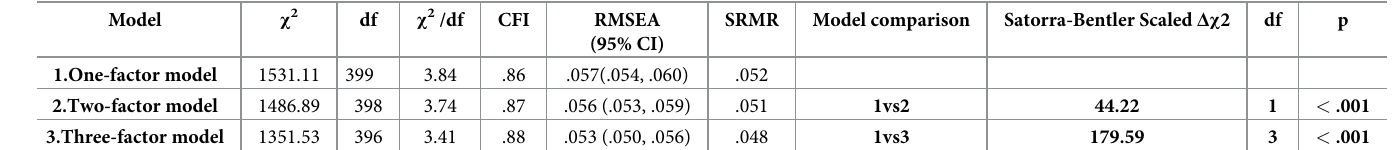
Table 1. Model fit indices from the confirmatory factor